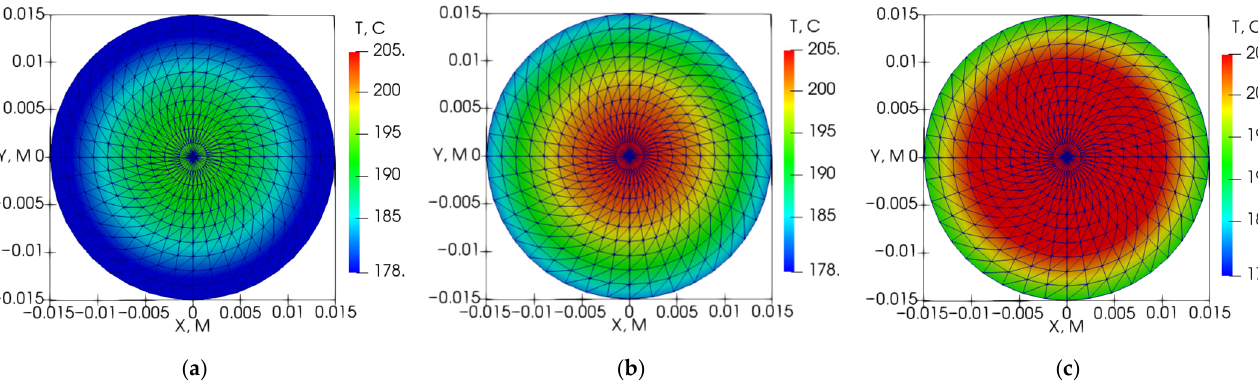
Figure 12. Temperature distribution in the average cross section of sample B3 under radio-frequency exposure at different times: ( a ) 9 min; ( b ) 10 min; ( c ) 11 min.